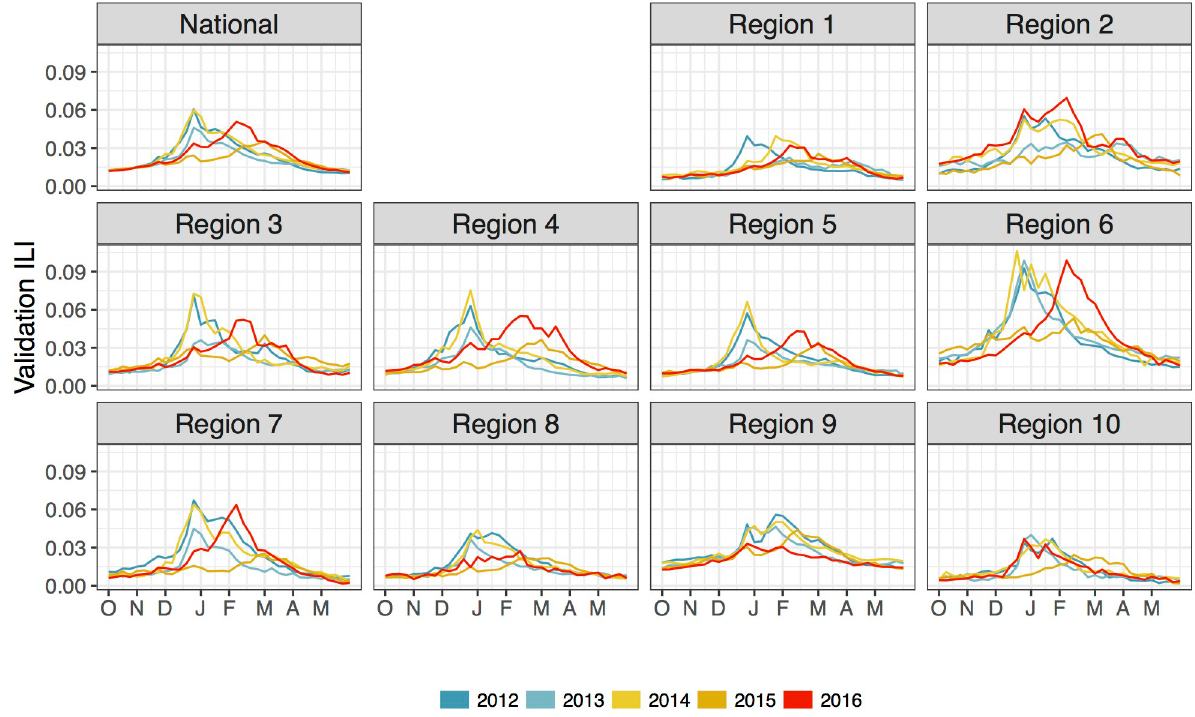
Fig 1. Validation ILI for the 2012 through 2016 flu seasons nationally and for all 10 HHS regions. For all regions, ILI is low at the beginning (October) and end (May) of the flu season, peaking between December and March. Different HHS regions have different ILI magnitudes, with Region 6 having more intense flu seasons, on average, than Region